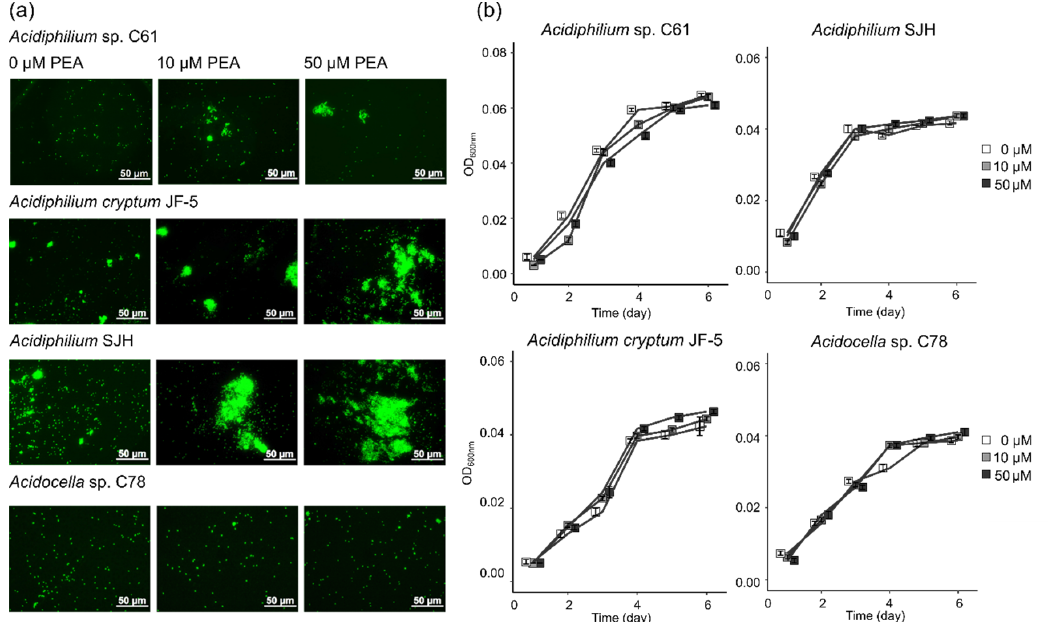
Figure 2. Effect of phenethylamine (PEA) on cell phenotype and growth of bacteria. (a) Fluorescence microscopy images of PEA-induced aggregate formation in Acidiphilium sp. C61, Acidiphilium cryptum JF-5, Acidiphilium SJH, and Acidocella sp. C78 incubations amended with increasing concentrations of PEA (0, 10, 50 µM) during aerobic growth. Total nucleic acids in subsamples taken after 3–4 days were stained with SYTO 13. (b) Aerobic growth curves (OD 600nm ) of Acidiphilium sp. C61, Acidiphilium cryptum JF-5, Acidiphilium SJH, and Acidocella sp. C78 (see methods for growth conditions) incubations grown with increasing PEA concentrations (0 µM, white square; 10 µM, grey square; and 50 µM, black square). Values represent means of triplicate samples ( n = 3); error bars represent one standard deviation.